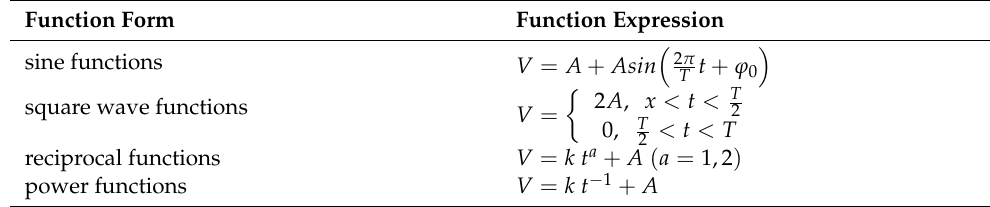
Table 1. Function expression of different feed modes.